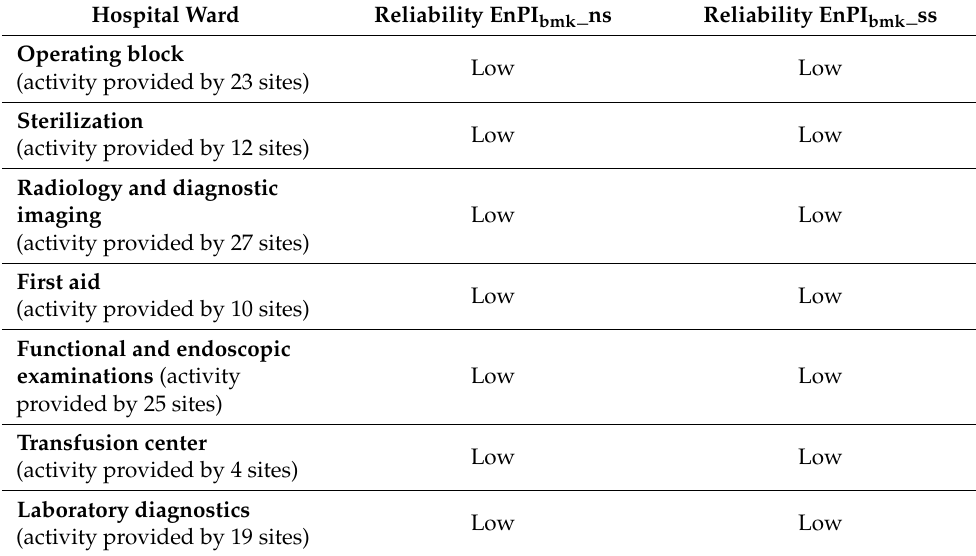
Table 4. Reliability evaluation for the EnPIs related to diagnosis and